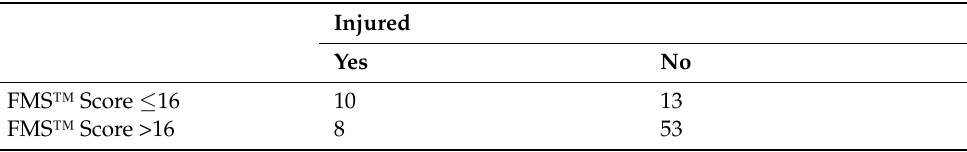
Table 3. 2 × 2 contingency table indicating if an athletes’ FMS score was above or below the optimal cut-off point and if they had reported injury